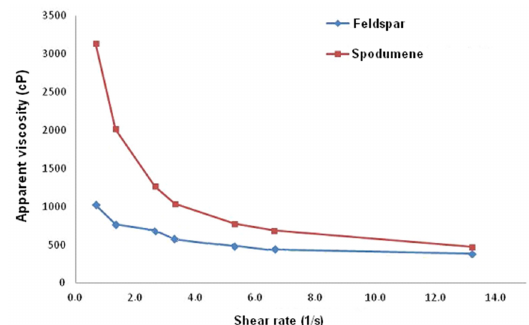
Figure 7. Shear stress in function of shear rate. 0.15% of dispersant was used for mixing.